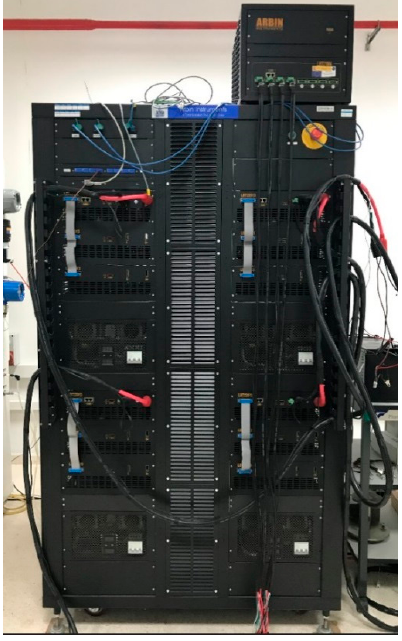
Figure 12: Arbin© battery test bench Figure 12. Arbin © battery test bench.